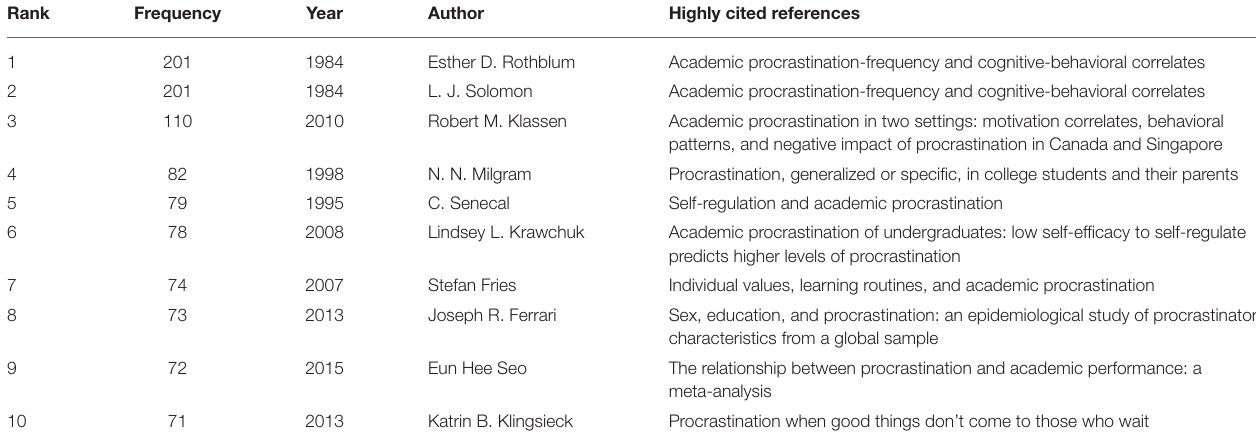
TABLE 5 | Top 10 cited authors and their highly cited articles: 1938–2021. Rank